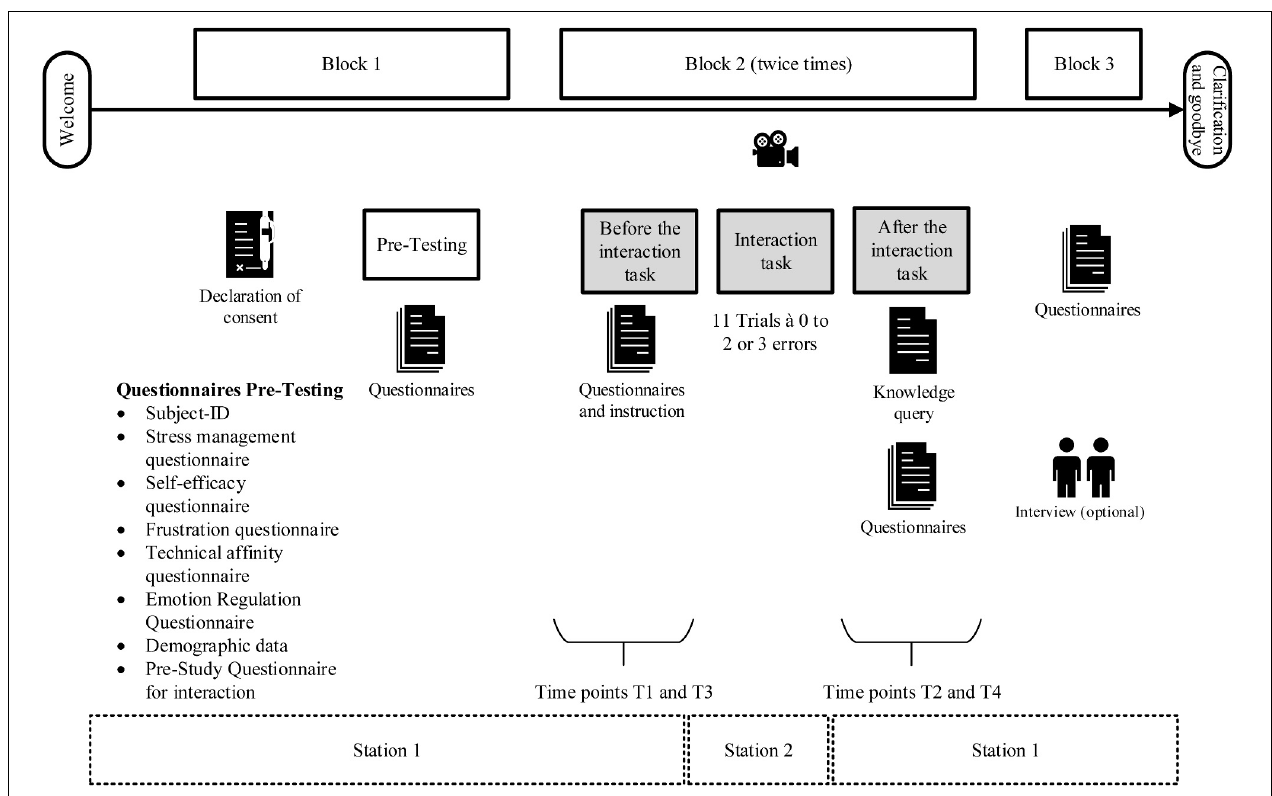
FIGURE 3 | Procedure of the human–robot interaction